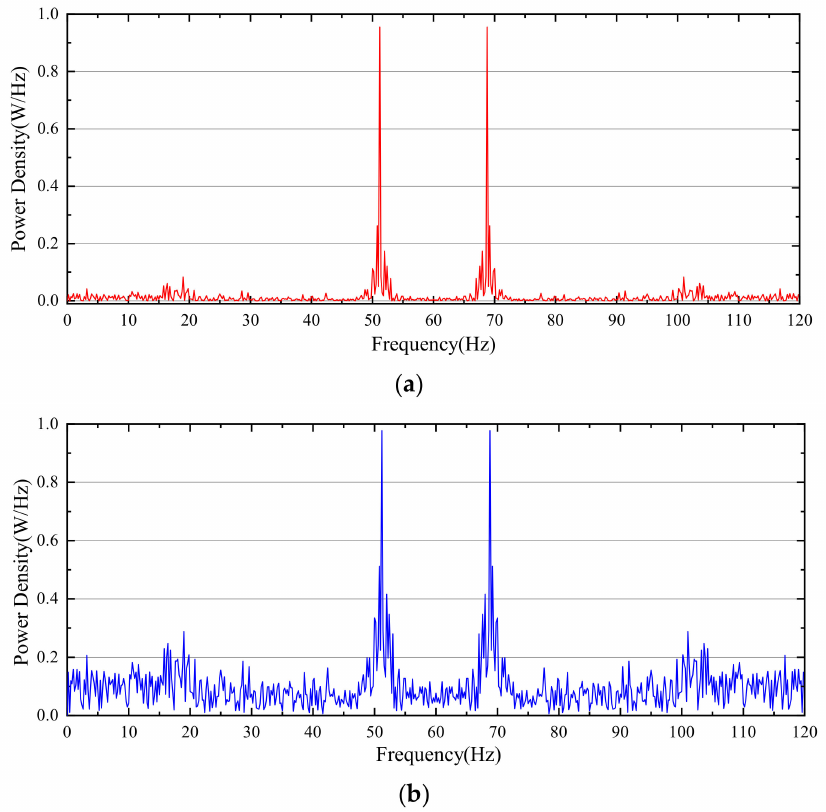
Figure 10. Frequency spectrum: ( a ) Surface average cavitation fraction; ( b ) Average